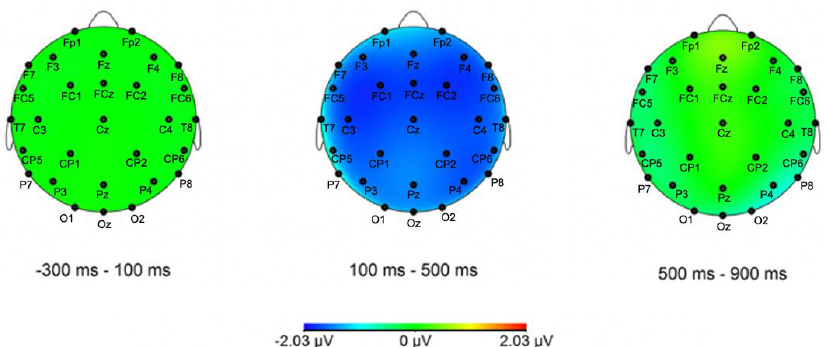
Figure 3. Grand Average ERP waveforms for the grammatical (black) and case morphology (red) conditions in Mini-Latin at electrodes P7, Cz and F4.